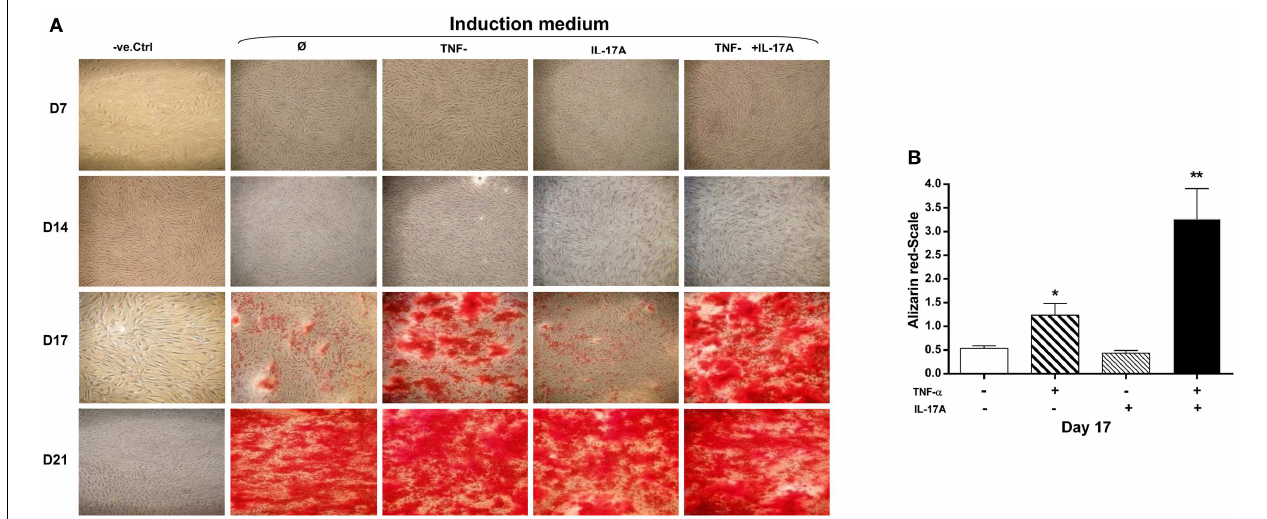
or both (column 5) were added or not to cultures. Plates were then stained with alizarin red, which colors calcium deposits in the extracellular matrix. (B) Results of day 17 were analyzed using theWilcoxon test. * p < 0.05; ** p < 0.005 vs. induction medium alone.